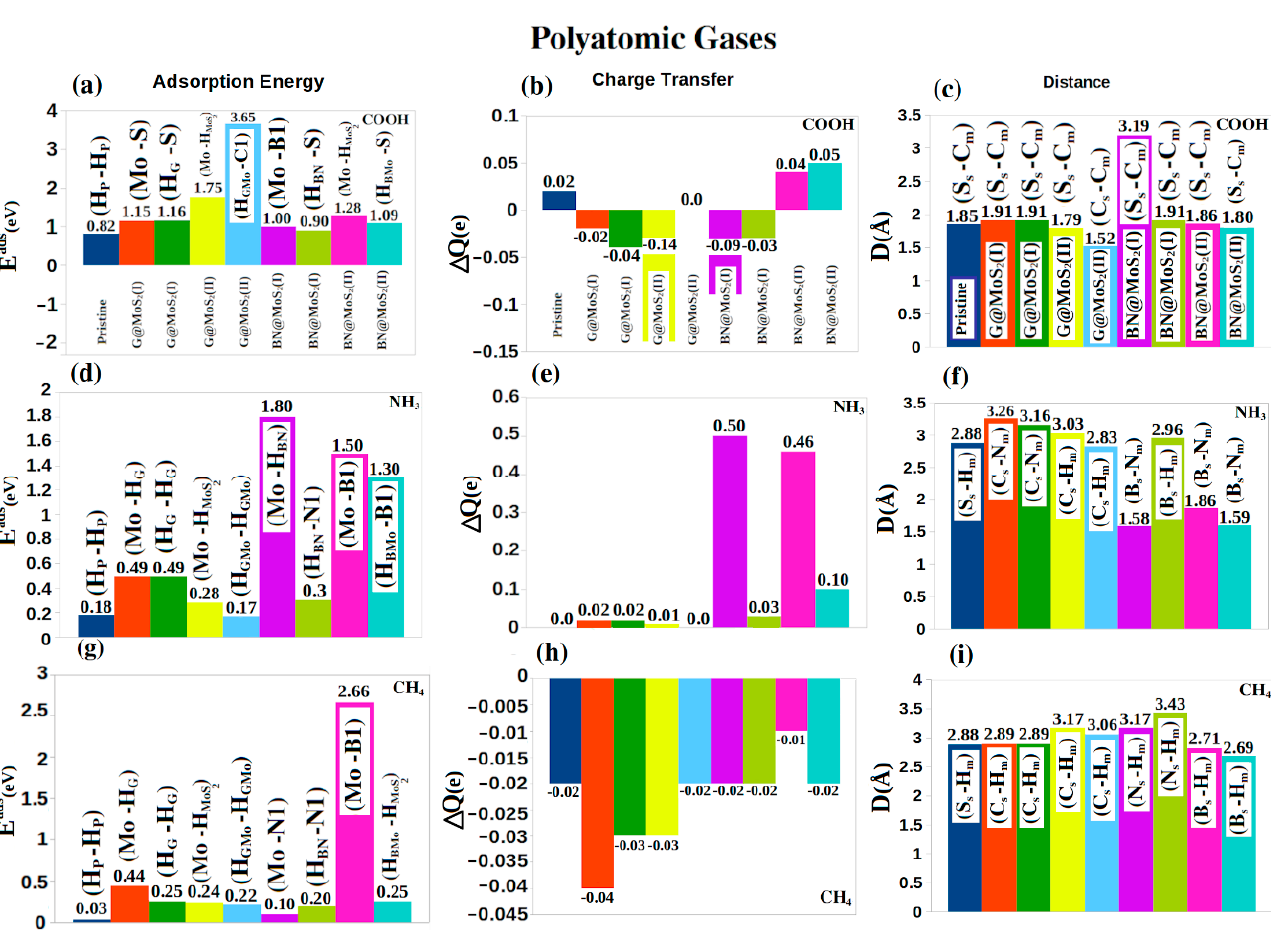
Figure 6. ( a – i ) From left to right, the adsorption energy ( E ad (eV), charge transfer ( Δ Q (e) and the closest distance (D(Å)) between the gas molecule (X m ) and the sheet (X s ) for polyatomic gases. From top to down COOH, NH 3 , and CH 4 gases are considered. The initial and final positions (Y, Z) of the adsorbed gases before and after optimization are shown in the adsorption energy figures (first column).